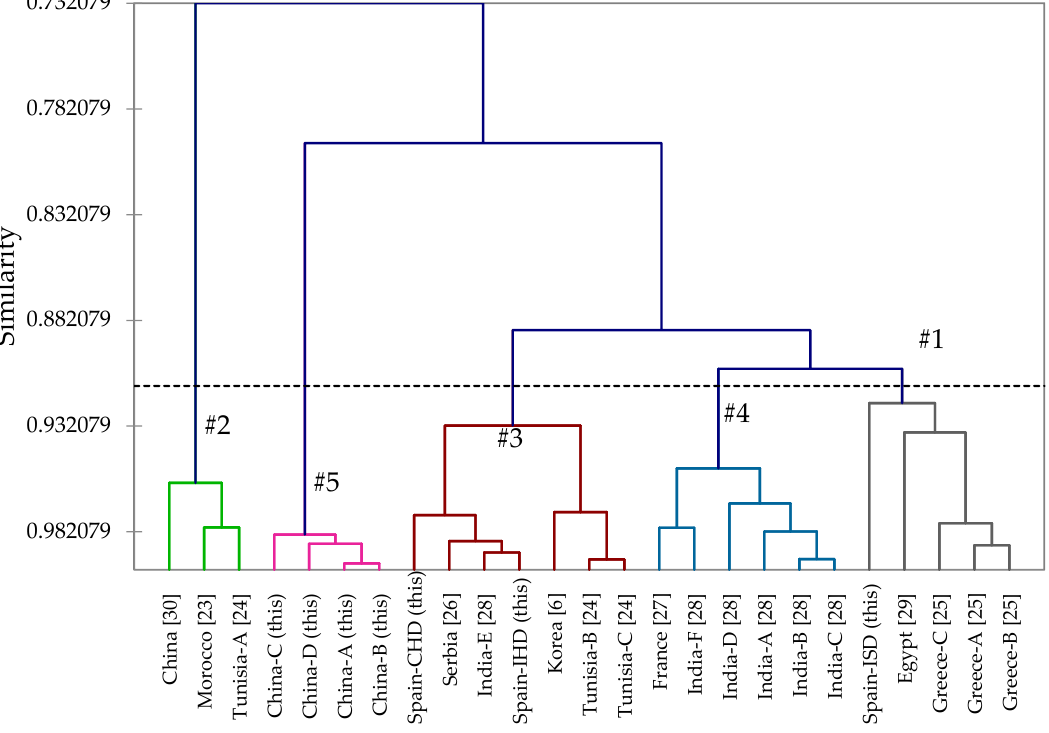
Figure 2. Dendrogram obtained from the agglomerative hierarchical cluster analysis of 25 Allium sativum essential oil compositions. Individual clusters are highlighted by different colored lines and numbers (#1–#5). The letters A–F refer to different essential oil samples from the same country of origin. CHD = Clevenger hydrodistillation; IHD = industrial hydrodistillation; ISD = industrial steam distillation.